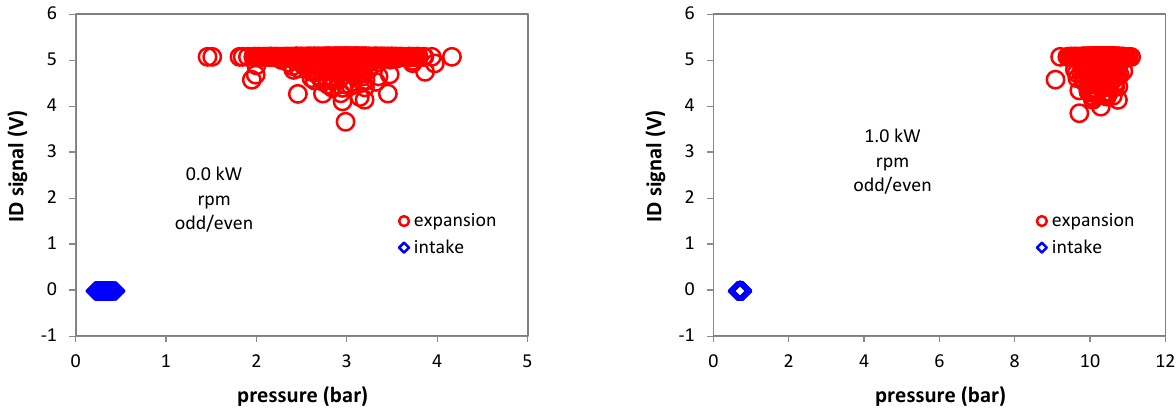
Figure 7. Series of odd/even turn-based rpm (diamond symbols) and spark duration (round symbols) values recorded during 20 consecutive cycles; median values (calculated based on the entire set of 200 cycles) are also shown with dashed lines.